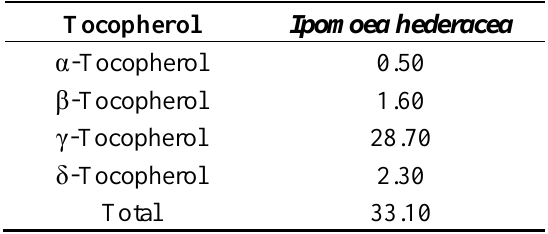
Table 7. Tocopherol profile (mg/100g) of I. hederacea seed